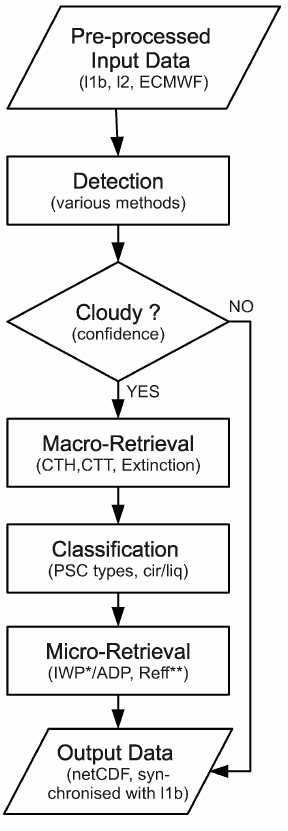
Fig. 1. Overview of the MIPclouds processing scheme. The pre- processing of the input data is part of the original cloud processor. ( ∗ ) Ice water path (IWP) is an integrated quantity over the limb path, as well as for the area density path (ADP). ( ∗∗ ) For the current processor version, retrieval results of R eff are not recommended for scientific analyses, further investigations and improvements on the algorithms are